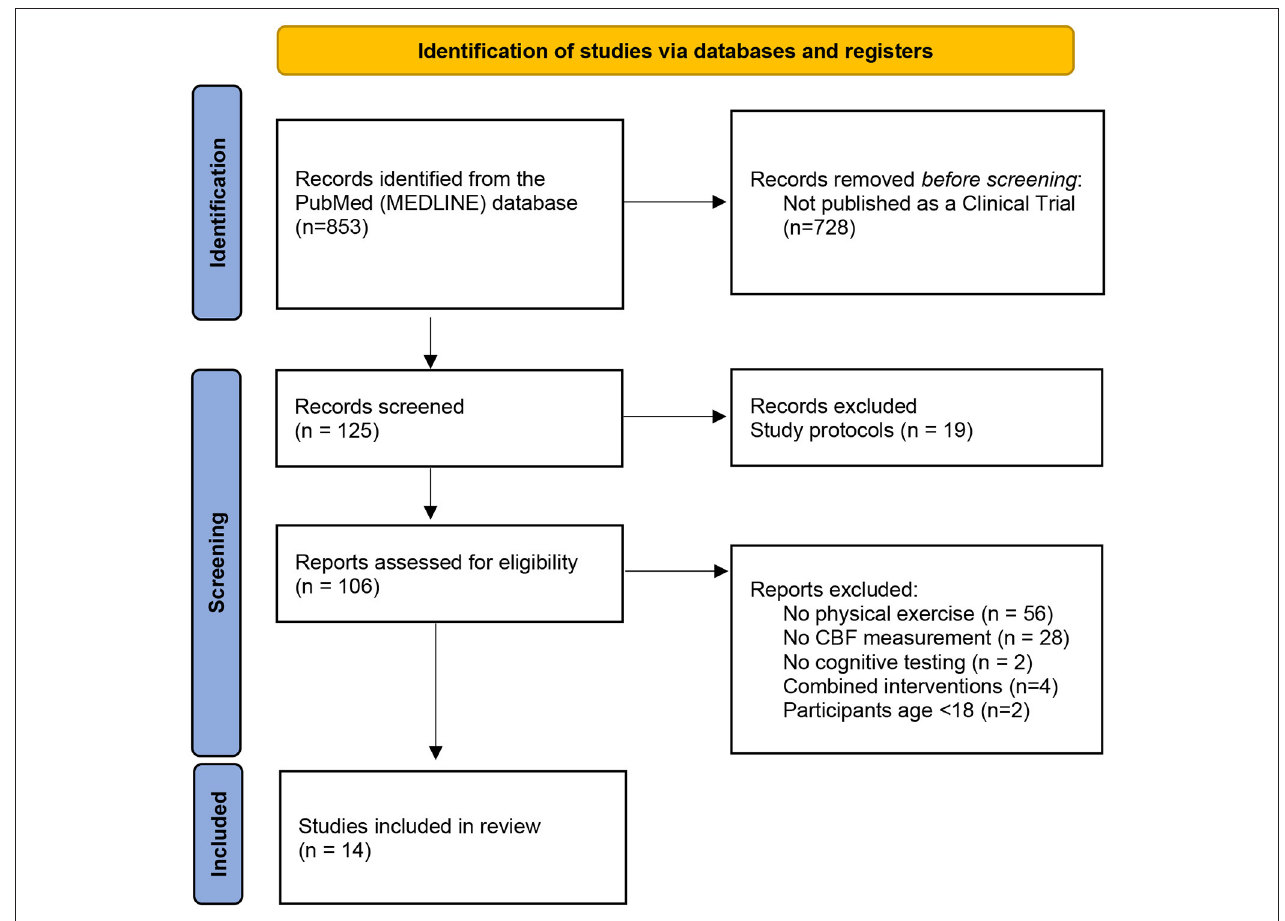
(b) measurement of the CBF rate, (c) cognitive